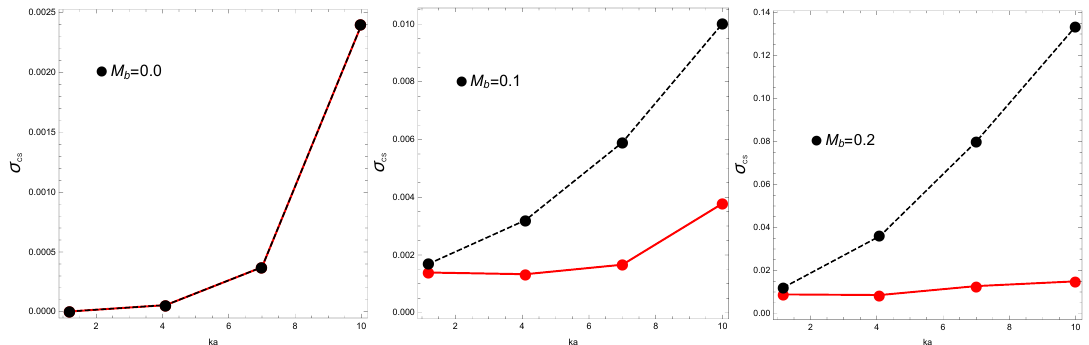
Figure 7. Scattering cross-section σ cs as a function of the reduced frequency ka at M b = 0.0,0.1,0.2. Black dashed lines for a static cloak; red continuous lines for a convective cloak.